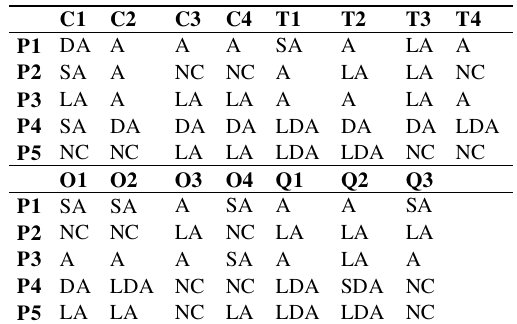
Table 7. Alternative press machine’s evaluations considering